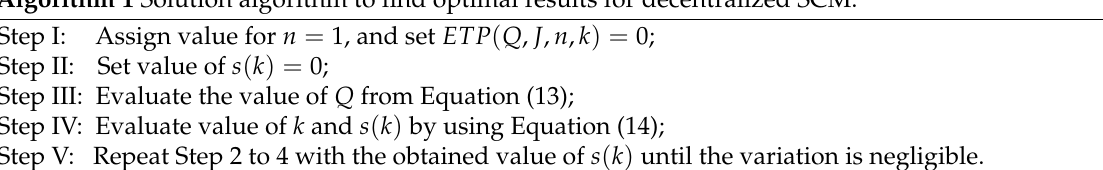
Algorithm 1 Solution algorithm to find optimal results for decentralized